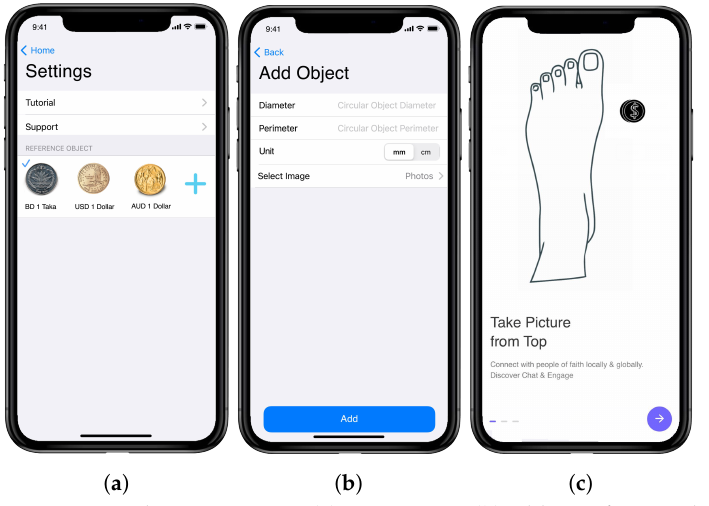
Figure 4. Application settings: ( a ) main screen; ( b ) adding reference object; ( c ) tutorial